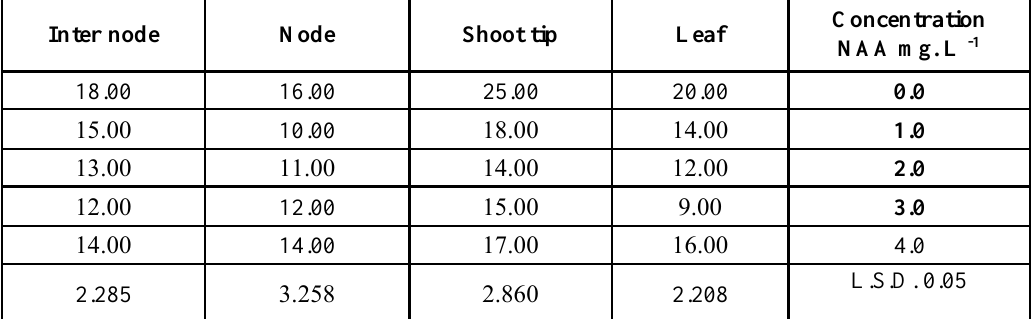
Table 6. Effect of BA and NAA Auxin and Their Interaction on Average Wet Weight (gm) of Leaf Stevia Callus in